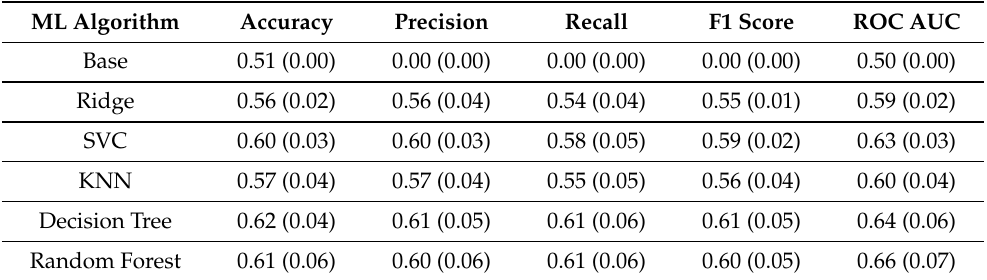
Table 9. EO prediction results (classification problem) using I-F features. Nested cross-validation with 10 outer and five inner splits. Classification problems on two classes: (a): High_EO (High Eudaimonic Orientated) and (b): Low_EO (Low Eudaimonic Oriented). Numbers are the mean value of 10 outer splits. Numbers in parenthesis indicate the standard deviation